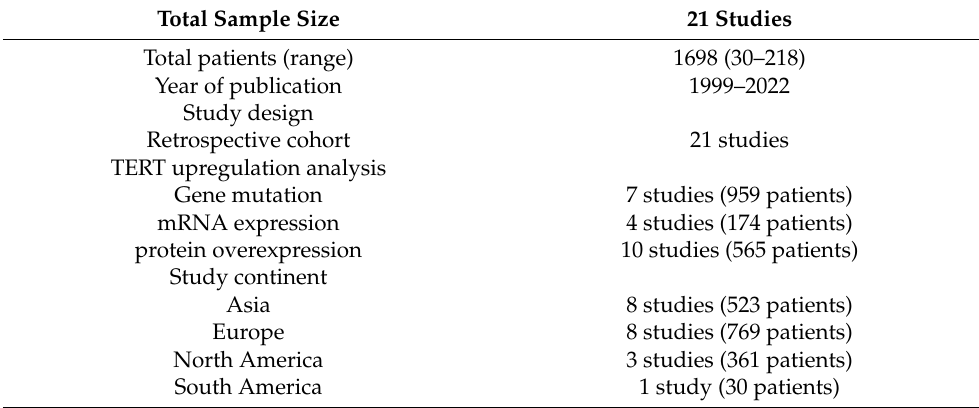
Table 1. Summary of the main characteristics of the study. Table S2 (Supplementary Materials) exhibits in detail the characteristics of each primary-level study included in this systematic re- view and meta-analysis.